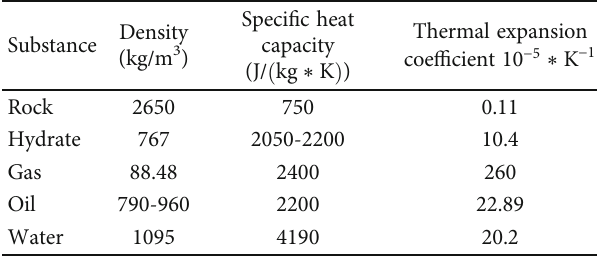
Table 2: Physical properties of di ff erent